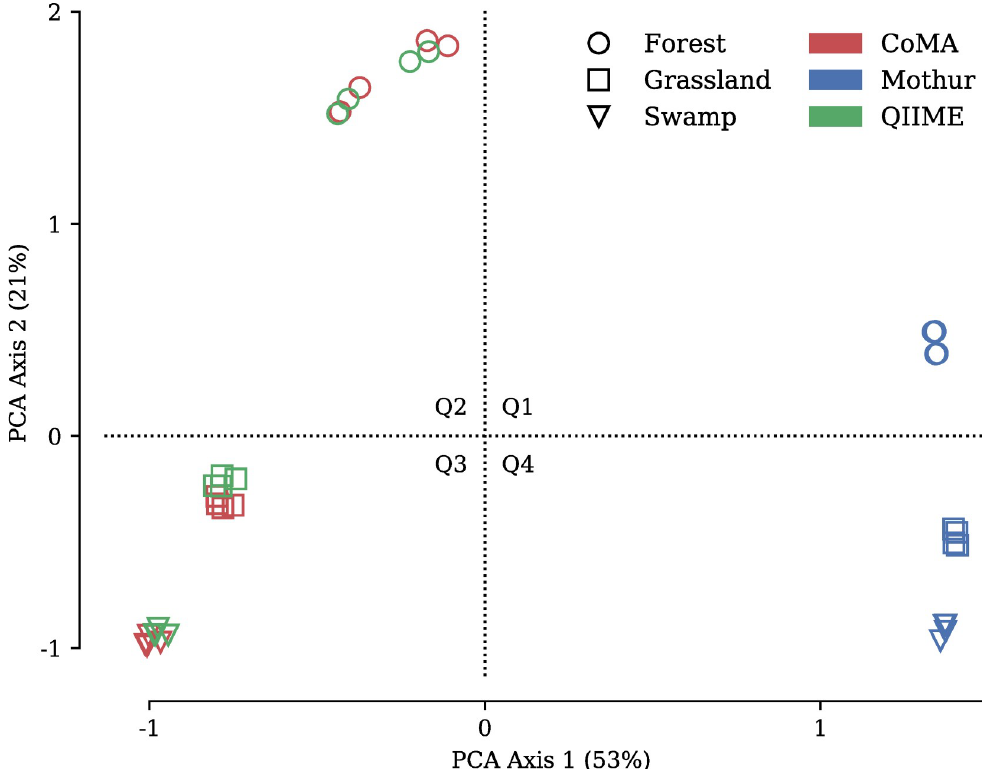
Fig 6. Principal component analysis based on archaeal and bacterial families of soil samples from three different habitats: Forest, grassland and swamp. The color code indicates the applied data analysis tool: CoMA, Mothur and QIIME. Q1—Q4 = quadrants of the coordinate